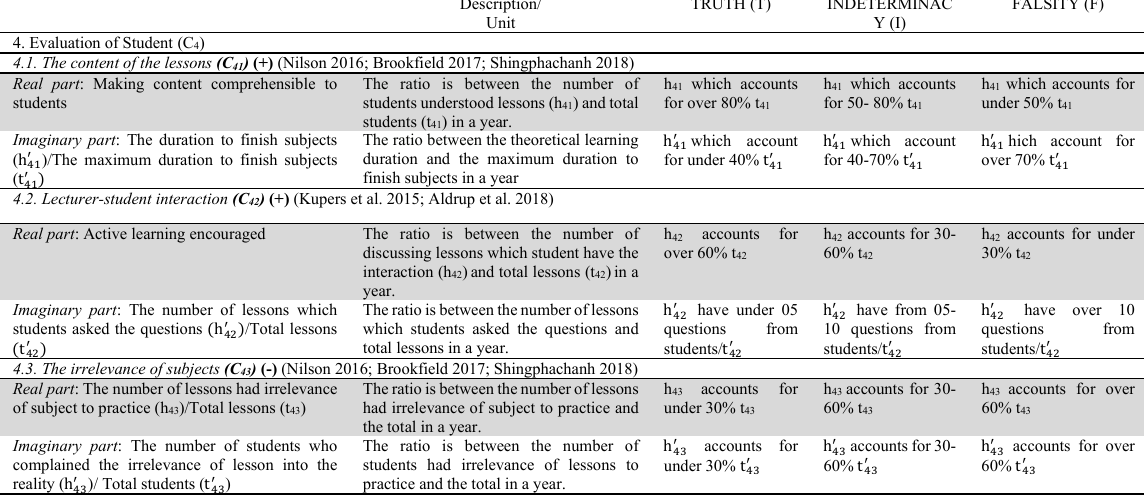
The hierarchical model for lecturer evaluation and calculation methods 4. Evaluation of Student (C 4 ) 4.1. The content of the lessons (C 41 ) (+) (Nilson 2016; Brookfield 2017; Shingphachanh 2018) Real part : Making content comprehensible to students